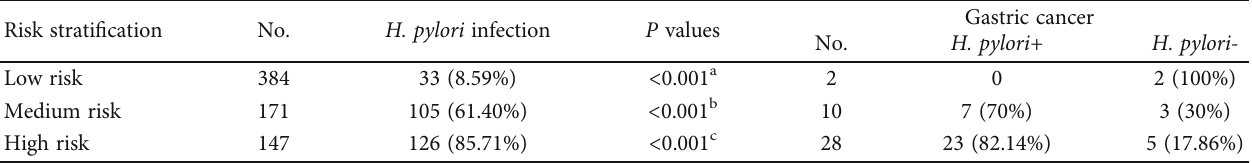
Table 3: Helicobacter pylori infection according to the Kyoto Classi fi cation of Gastritis.